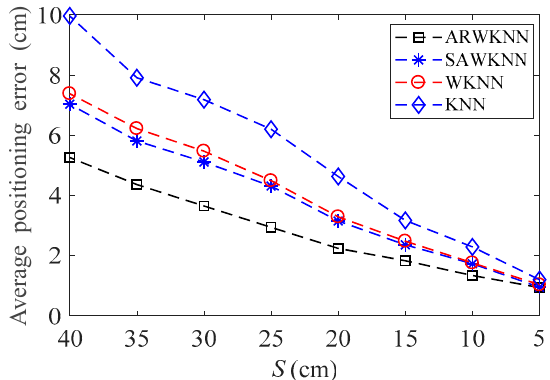
Figure 13. In 3-D, the impact of S on the average positioning error with K max = 8.